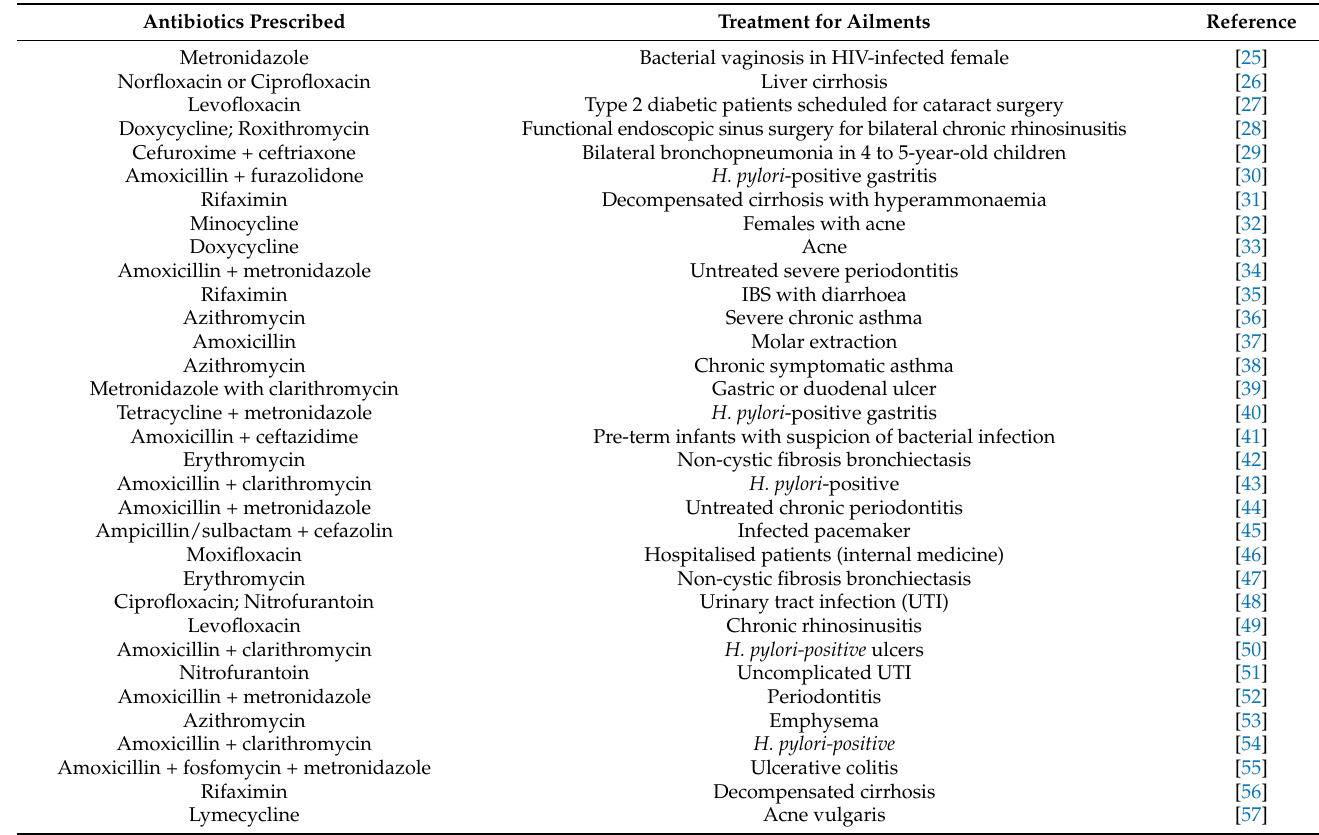
Table 1. Types of antibiotics prescribed for the treatment of different health